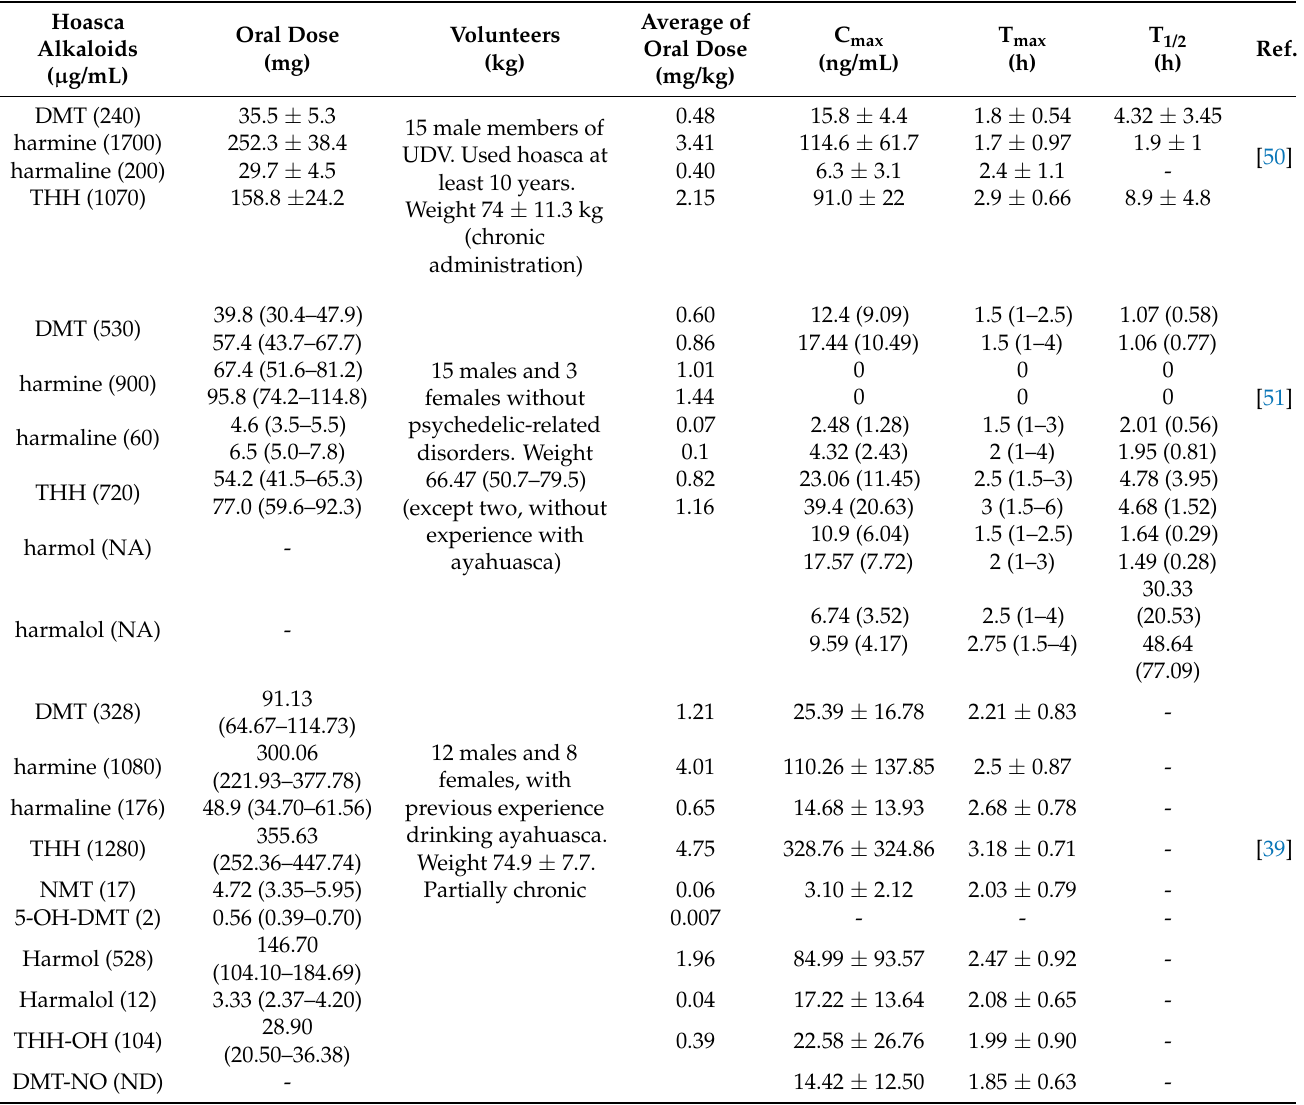
Table 4. Human pharmacokinetics of